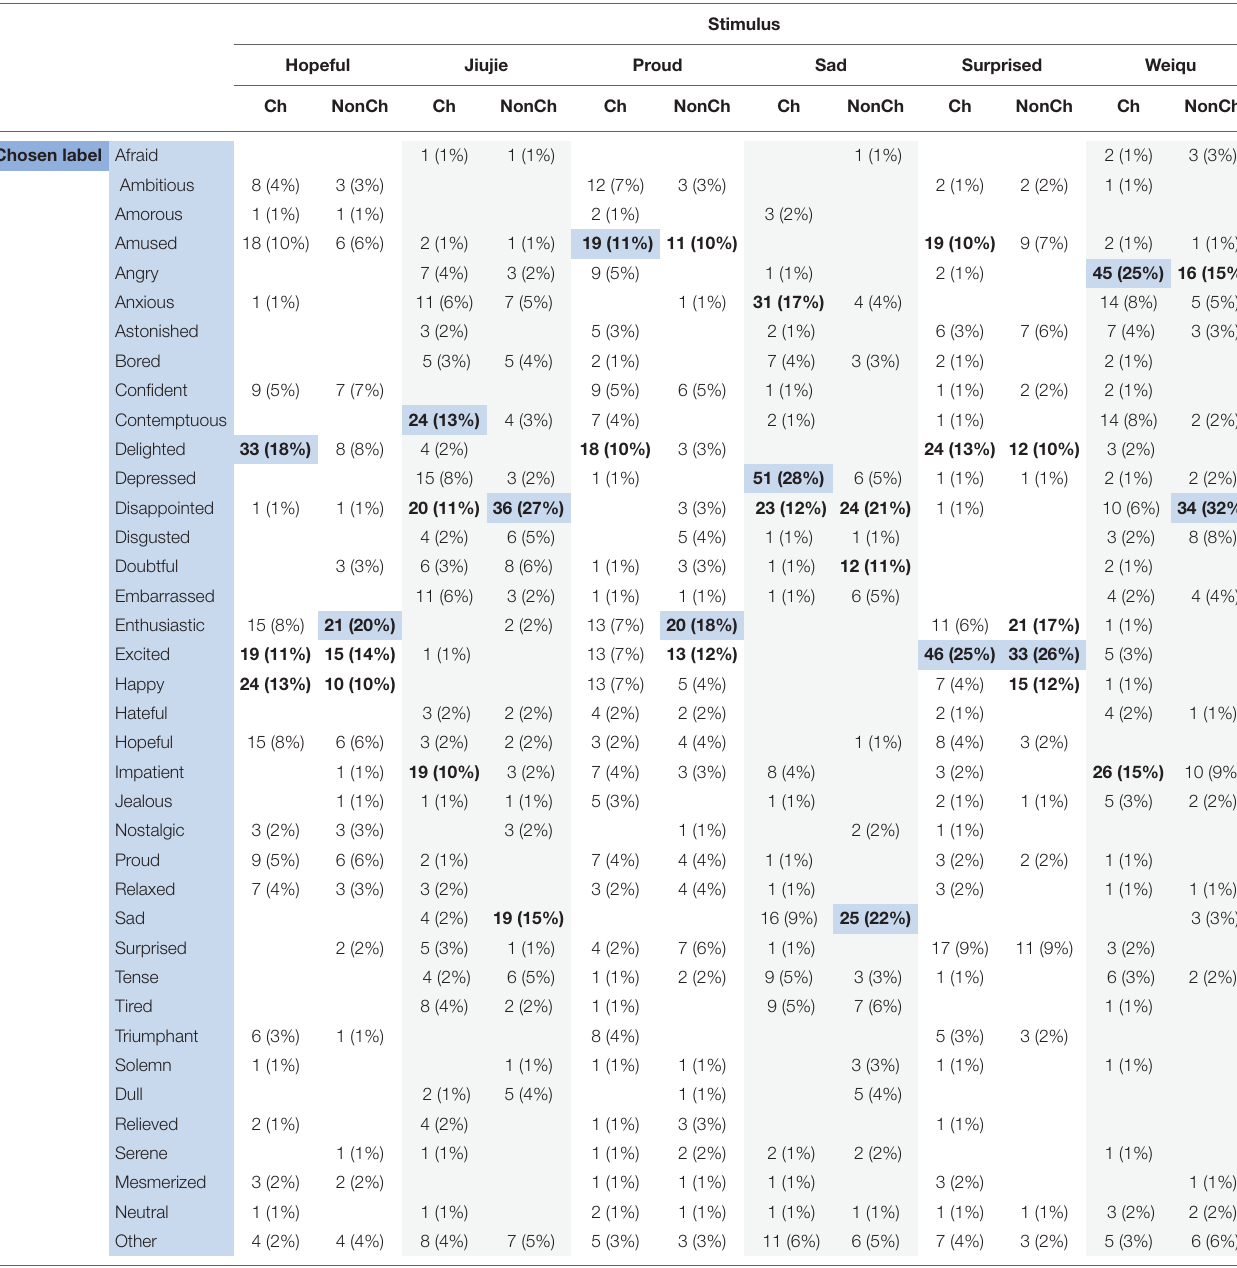
TABLE 3.2 | Frequencies of the label chosen to describe the emotion perceived in each stimulus, with the highest frequency highlighted in blue, frequencies of 10% or more printed in bold, and frequencies of 2% or less printed in gray for ease of reading (105 < n < 313). Stimulus Hopeful Jiujie Proud Sad Surprised Weiqu Ch NonCh Ch NonCh Ch NonCh Ch NonCh Ch NonCh Ch NonCh Chosen label